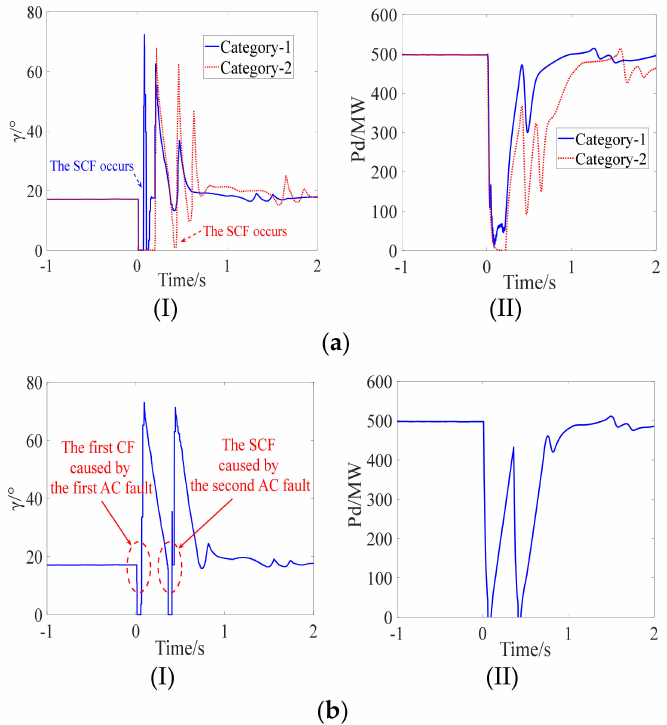
Figure 1. Simulation results of SCFs. ( a ) SCF corresponding to Category 1 and Category 2, ( I ) Ex- tinction angle and ( II ) DC power; ( b ) SCF corresponding to Category 3, ( I ) Extinction angle and ( II ) DC power.